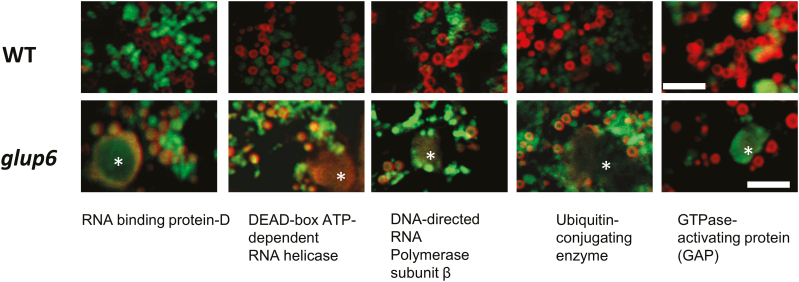
Mislocalization of mRNAs encoding RBP-D, DEAD-box ATP-dependent RNA helicase, RNA polymerase subunit b, ubiquitin conjugating enzyme, and GTPase-activating protein in the glup6 mutant compared with the wild-type (WT). All panels represent merged images of endosperm sections where Rhodamine staining (red) has been superimposed on the fluorescence staining patterns generated by in situ RT-PCR depicting the distribution of each individual RNA (green). With the exception of GTPase-activating protein, the mRNAs are mislocalized to the protein body-ER (PB-ER) and to the paramural bodies (PMB; indicated with asterisks) in the glup6 endosperm. The transcript for GTPase activating protein is found on the cisternal-ER and PMBs, and is not observed on the PB-ER in glup6. See Supplementary Fig. S2 for individual Rhodamine staining and RNA localization distribution patterns generated by in situ RT-PCR. Scale bars are 5 µm.